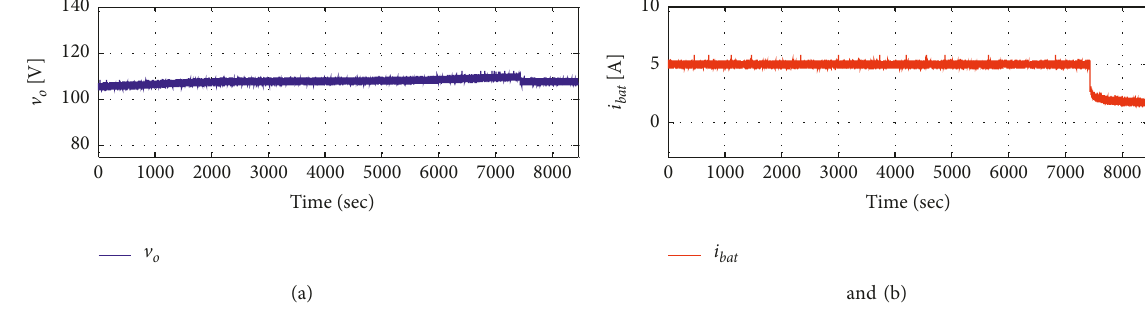
Figure 17: Experimental results of (a) battery voltage and (b) battery current in CC/CV.